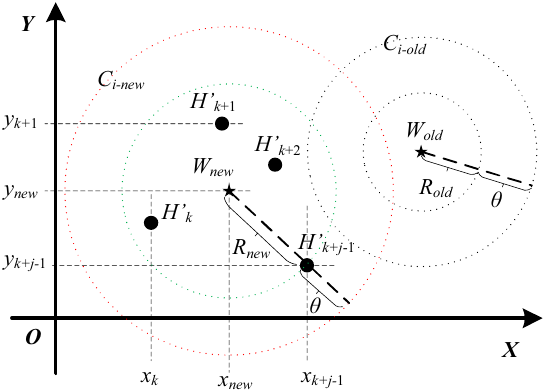
Figure 10. Principle map of model update of physical-layer channel